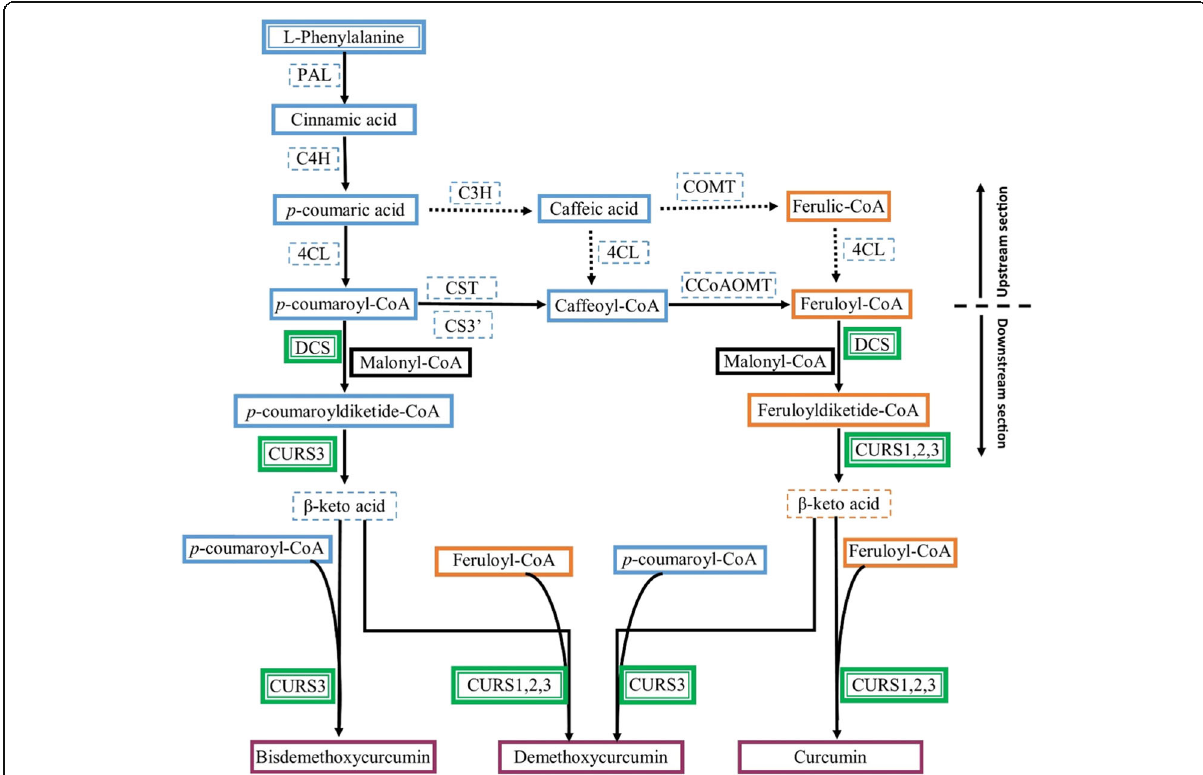
Fig. 4 Curcuminoid biosynthesis pathway in turmeric [adapted and modified from Ramirez-Ahumada et al. [14] and Katsuyama et al. [19, 20]]. Cinnamic acid is synthesized from phenylalanine by phenylalanine ammonia lyase ( PAL ) and converted into coumaric acid by cinnamate-4- hydroxylase ( C4H ). Then, 4-coumarate-CoA ligase ( 4CL ) converts coumaric acid into coumaroyl-CoA, and p -coumaroyl shikimate transferase ( CST ), p -coumaroyl 5- O -shikimate 3-hydroxylase ( CS3=H ), and caffeoyl-CoA- O -methyltransferase ( CCoAOMT ) convert it into feruloyl-CoA. Coumaroyl-CoA and feruloyl-CoA are then converted by diketide-CoA synthase ( DCS ) into diketide-CoAs by condensation with malonyl-CoA. In the end, multiple curcumin synthases ( CURS1 , CURS2 , and CURS3 ) catalyze the formation of curcuminoids by condensing the diketide-CoAs with coumaroyl-CoA and feruloyl-CoA. Depending on the combination, different curcuminoids are produced, namely curcumin, demethoxycurcumin, and bisdemethoxycurcumin. The route indicated by solid arrows corresponds to the central phenylpropanoid pathway that occur in vivo, in C.